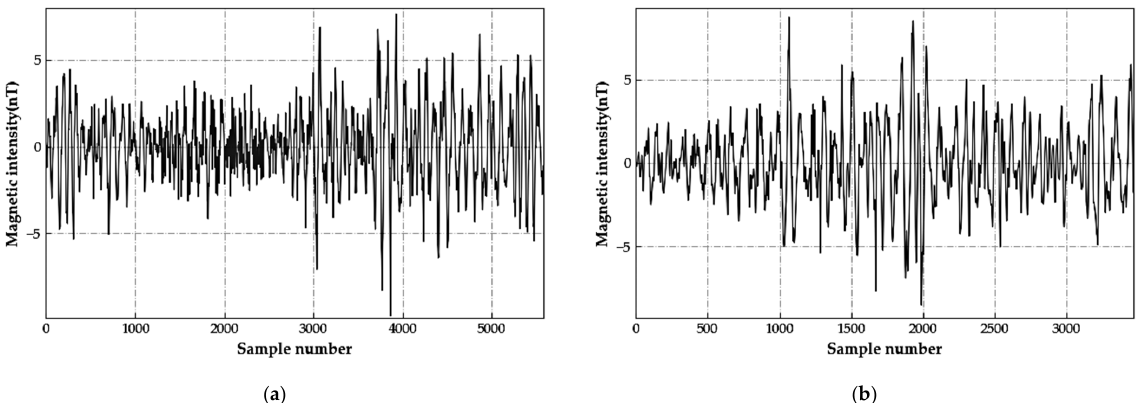
Figure 4. The FOM flight path. The square represents the beginning of the flight, and the diamond represents the end of the flight.